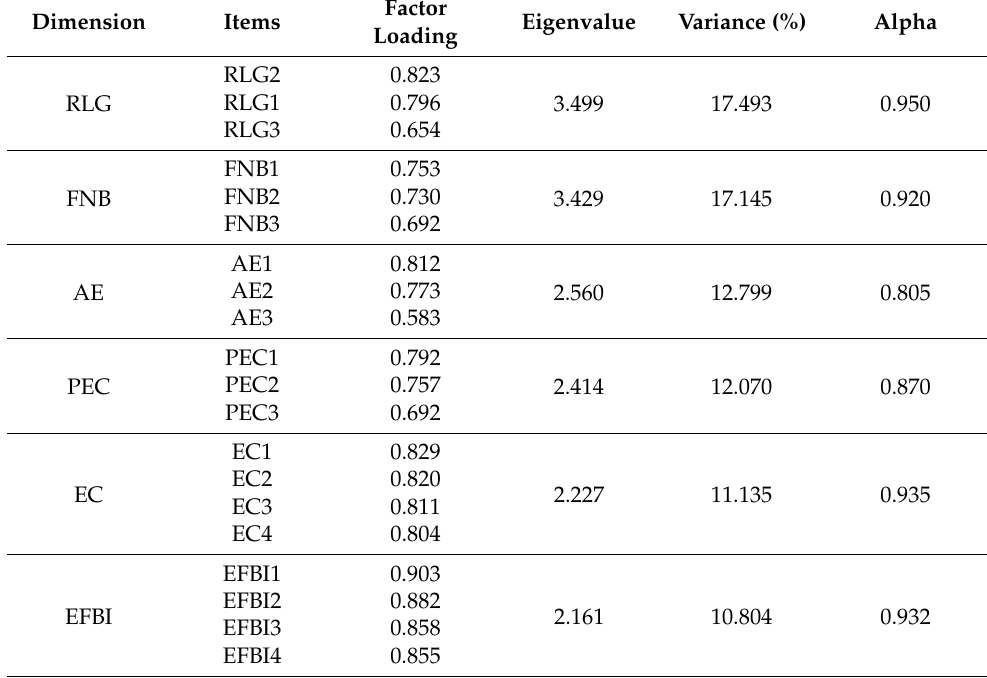
Table 2. Exploratory factor analysis and reliability of analysis results.